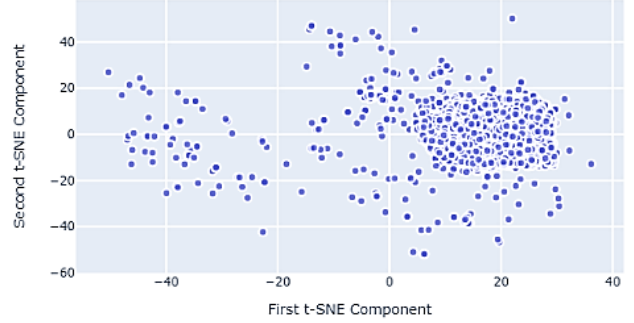
Figure 1. Two-dimensional distribution of MNIST data (digit 3) using t-SNE. As indicated, the data distributed in the neighborhood have similar characteristics.